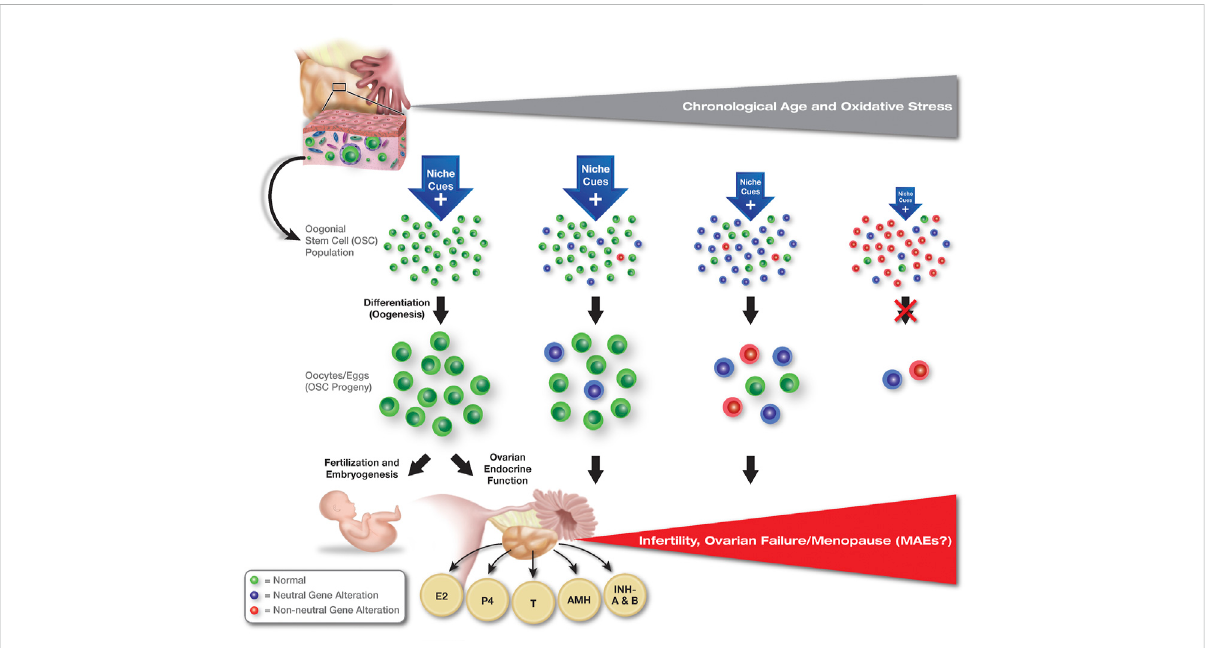
FIGURE 2 Hypothesized role of clonal heterogeneity and non-neutral selection in the progressive quiescence of OSCs with age. Contrasting the continuation of spermatogenesis in males at advanced chronological ages, even in the face of sel fi sh SSC selection (see Figure 1), oogenesis in femalesshutsdownwithage.Accordingly,oocytelossthroughfollicleatresiaisnolongerpartiallyoffsetbytheformationofnewoocyte-containing follicles, leading to exhaustion of the oocyte reserve and ovarian failure (see Wang et al., 2017 for details). Oogonial stem cells are known to persist in ovaries into advanced ages, but the cells lose the capacity to differentiate into new oocytes in vivo . These fi ndings suggest that OSCs become quiescent with age, although the cues that drive this, and the mechanisms underlying the progressive impairment in differentiation potential, are currently unknown. Abbreviations: E2, estrogen; P4, progesterone; T, testosterone; AMH, anti-Müllerian hormone; INH-A and B, inhibin-A and